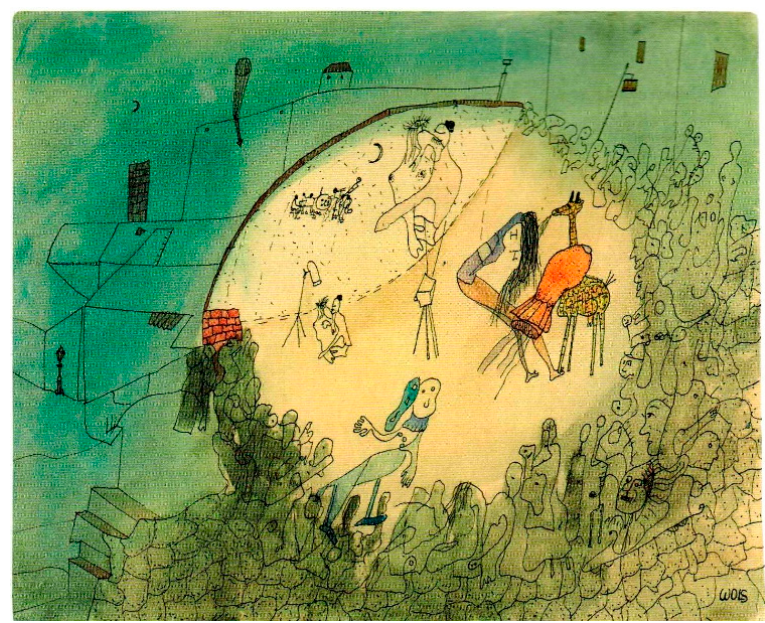
Figure 6. Wols, The Circus ; Simultaneous View and Projection , c. 1940. Ink and watercolor on paper, 23 cm × 29 cm. Bremen, Karin und Uwe Hollweg Sammlung. © Adagp, Paris, 2020/Courtesy Karin und Uwe Hollweg Sammlung.